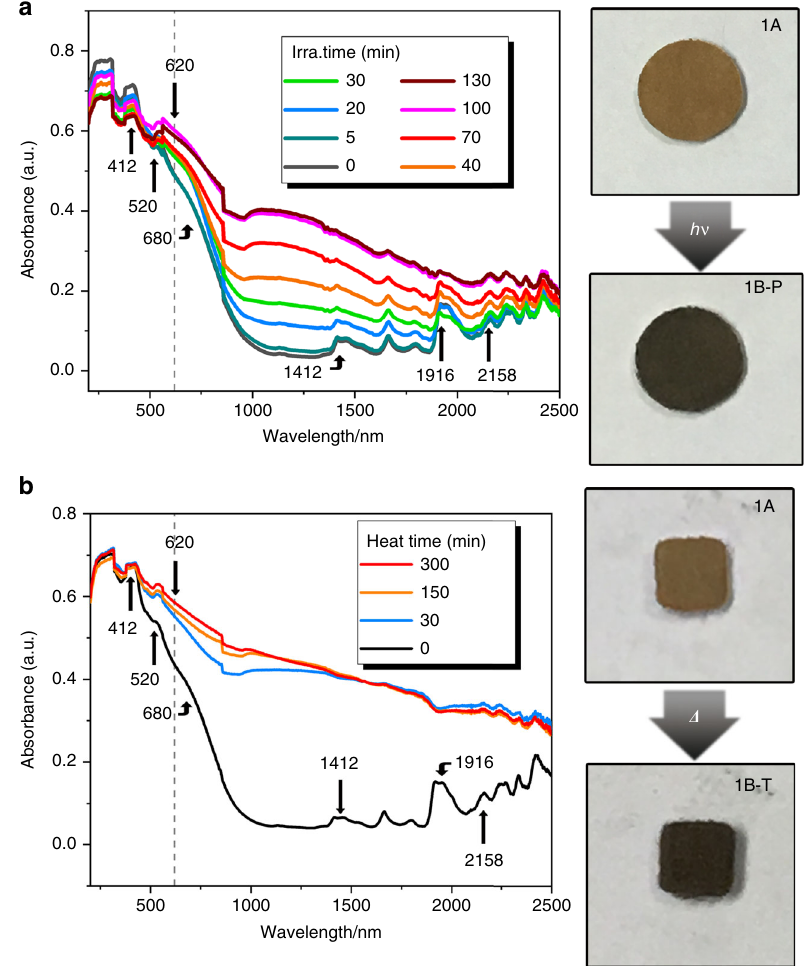
Fig. 3 Electron absorption spectra and color change. Time-dependent electron absorption spectra of 1 measured in the diffuse re fl ectance mode and color change upon irradiation ( a ) or thermal annealing at 180 °C ( b ).